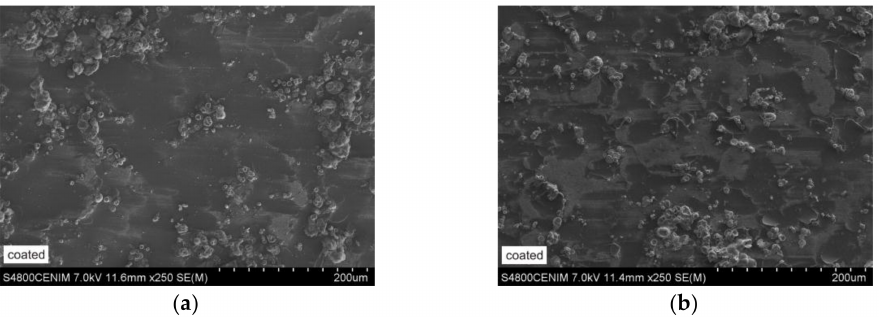
Figure 11. FESEM image of a steel substrate after the weathering test under organic acids atmosphere: ( a ) Coated area (La(Ac) 3 doped coating); ( b ) Coated area (La(NO 3 ) 3 doped